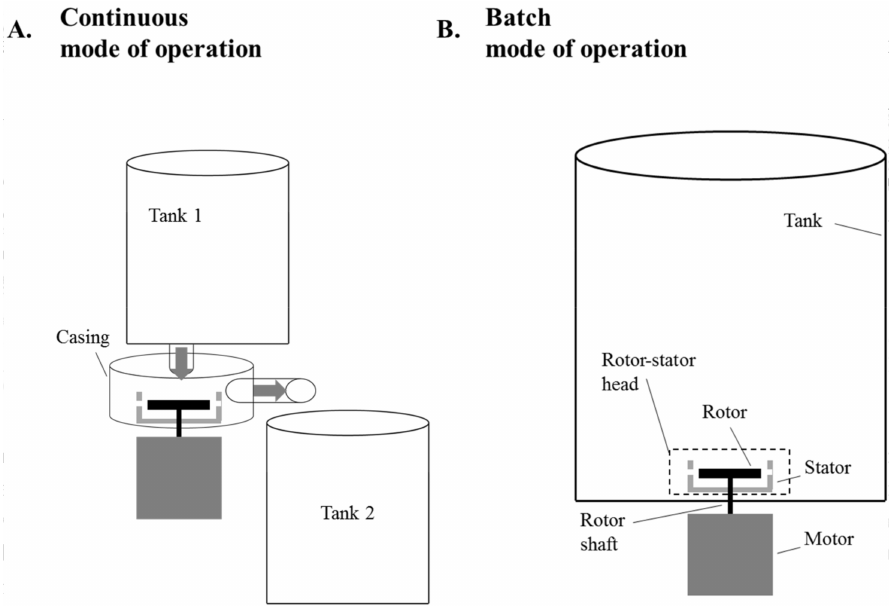
Figure 1. Schematic drawings of rotor-stator mixers (RSMs) operated in continuous ( A ) and batch ( B ) mode of operation.